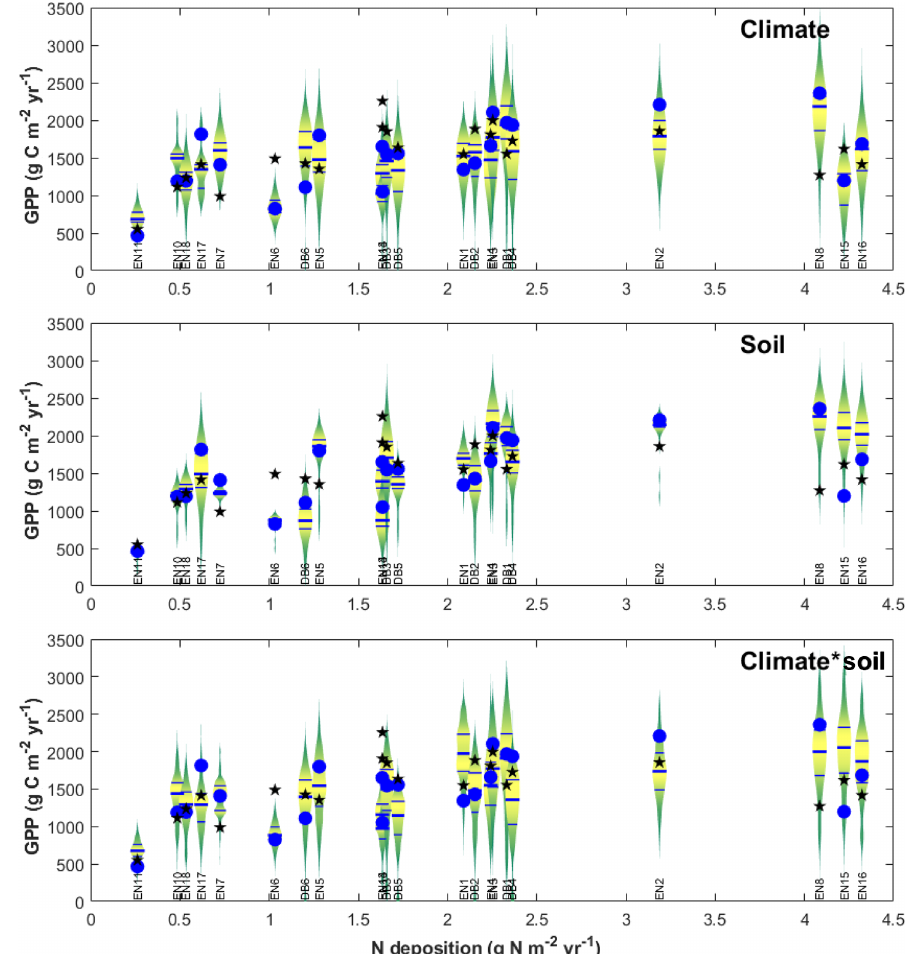
Figure 6. Input sensitivity study for gross primary productivity (GPP) modelled at each forest monitoring site for different soil/climate scenarios (vertical violin plots), compared with model base runs GPP base (blue circles) and EC-derived GPP obs (black stars). The data are displayed as a function of N r deposition over the CEIP–NEU measurement periods, for n = 22 deciduous broadleaf (DB) and coniferous evergreen needleleaf (EN) forest ecosystems. For each site, the violin plot shows the range and distribution (median, quartiles) of GPP modelled at the site using climate and/or soil input data from all 22 sites, showing the sensitivity to model inputs other than N deposition. See text for